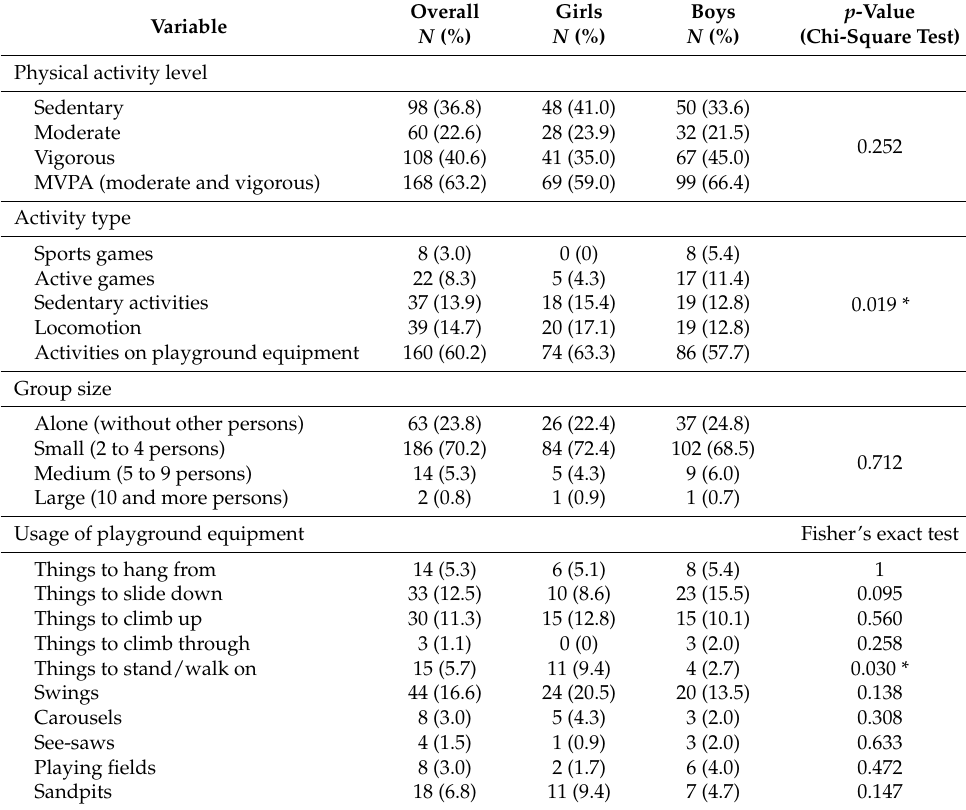
Table 2. Physical Activity and Play Behavior of Children Observed in the